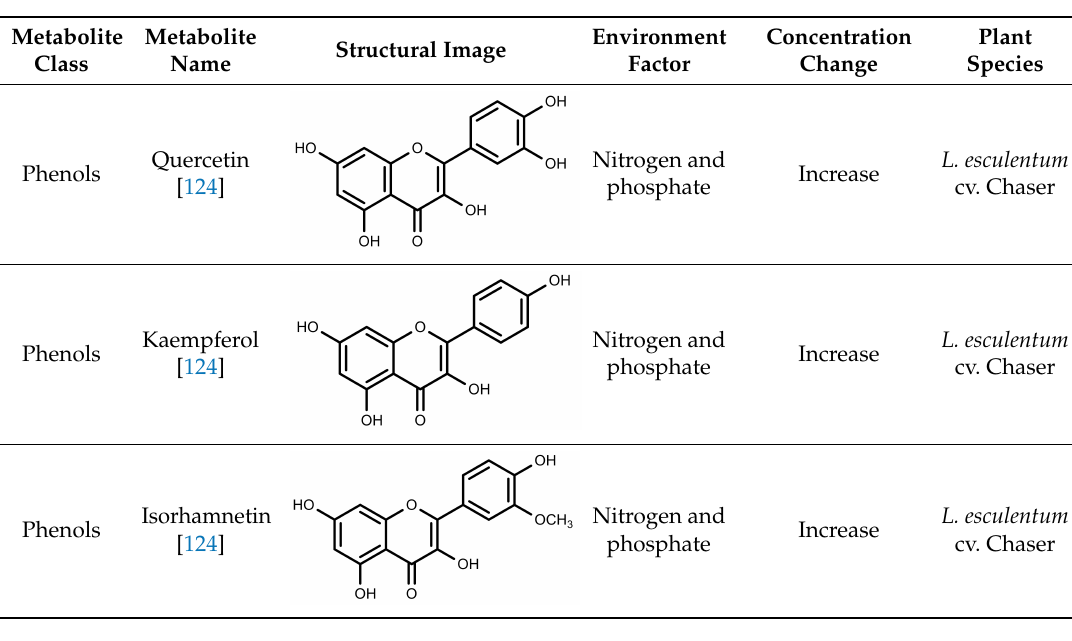
Table 7. Soil fertility change on the content of various plant